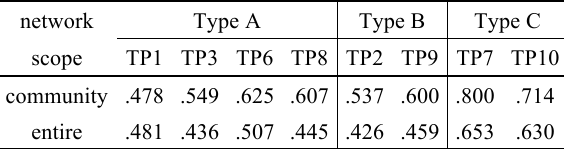
Reciprocity of communities and entire